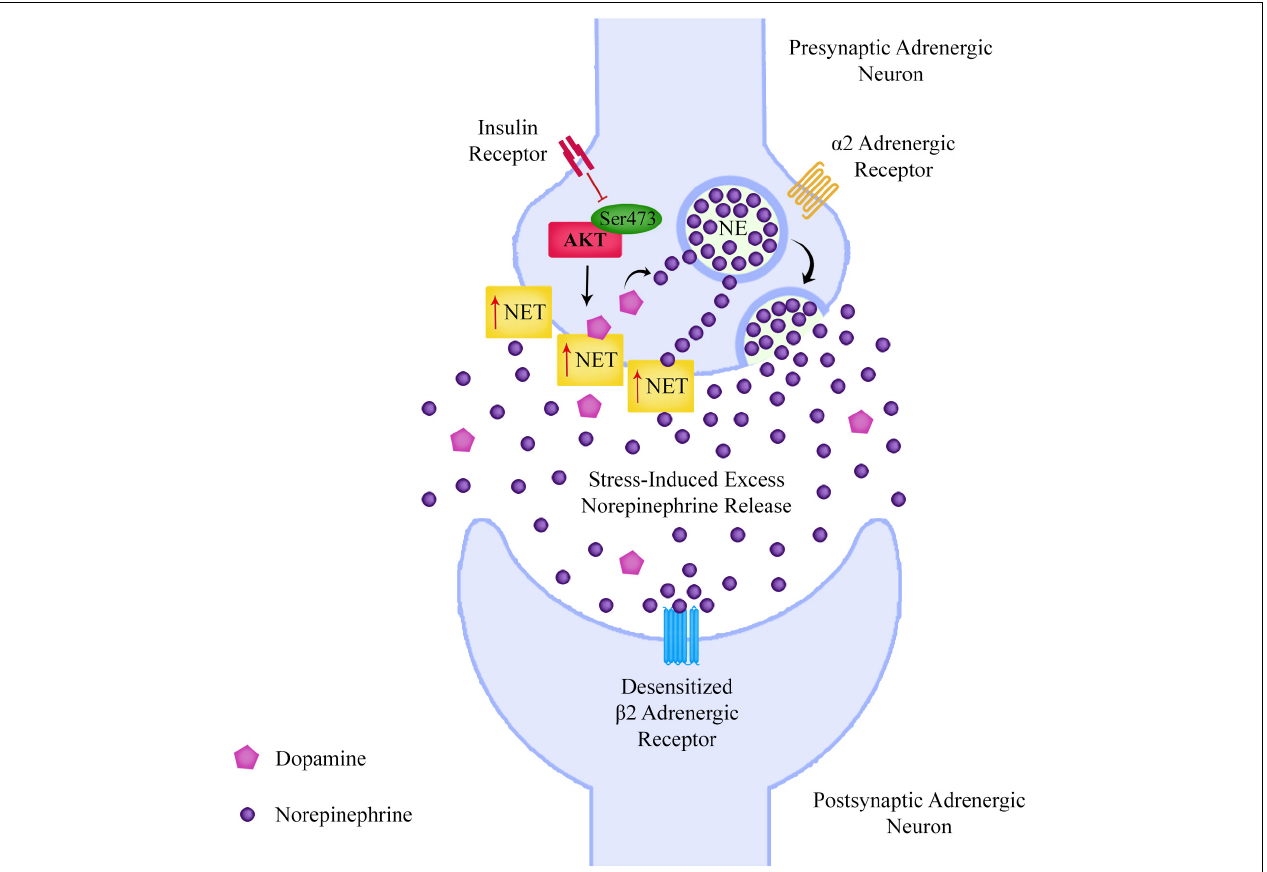
FIGURE 4 | If reduced Akt Ser473 phosphorylation is leading to increased adrenergic surface norepinephrine transporter expression and a consequent build-up of presynaptic norepinephrine, this could lead to excessive norepinephrine release during periods of stress, which could desensitize adrenergic receptors such as the beta-2 adrenergic